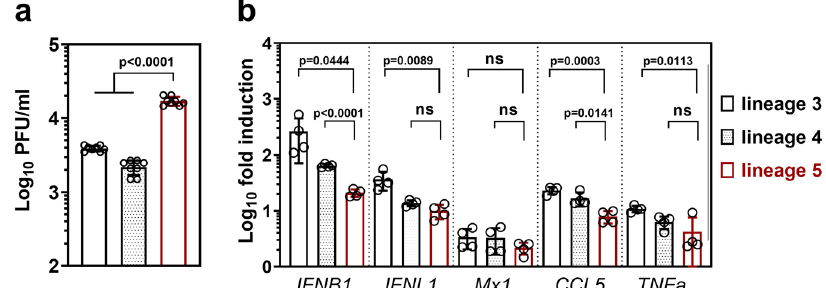
Fig. 7 Lineage 5 MERS-CoV strains show reduced immune gene induction. Calu-3 cells were infected with n = 2 isolates of each phylogenetic lineage with a high multiplicity of infection (MOI = 2) for subsequent quantitative real-time RT-PCR (q-RT-PCR) analysis of key immune genes. a Infectious virus production at 12 hpi was quanti fi ed by plaque assay. Shown are the results of two independent experiments with biological duplicates of n = 2 virus isolates, with bars indicating the mean and error bars indicating SD. b Immune gene induction as quanti fi ed by q-RT-PCR on lysed Calu-3 cells 12 hpi, expressed as fold induction over the noninfected control cells, normalized to the housekeeping gene TBP. The mean mRNA inductions of biological duplicates of n = 2 independent experiments with n = 2 virus isolates per lineage is shown with bars indicating the mean and error bars indicating SD. Statistical signi fi cance of differences in virus replication and fold inductions between lineage 5 and lineage 3 or 4 were analyzed by two-tailed, unpaired t -tests. PFU, plaque forming units; IFNB1, interferon beta 1; IFNL1, interferon lambda 1; CCL5, C-C motif chemokine ligand 5; TNFa, tumor necrosis factor-